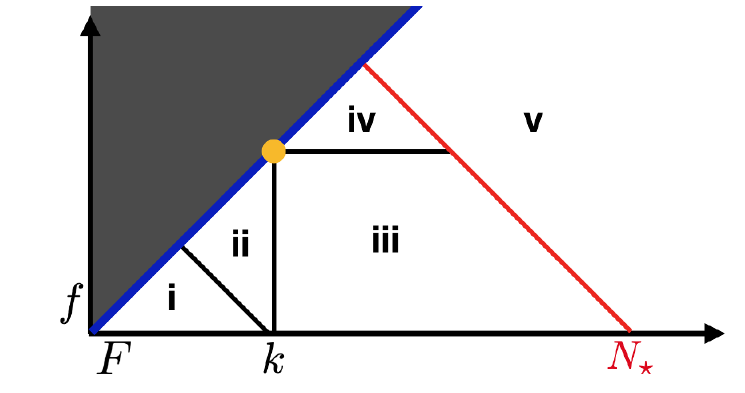
Figure 9 . Phases as a function of f and F